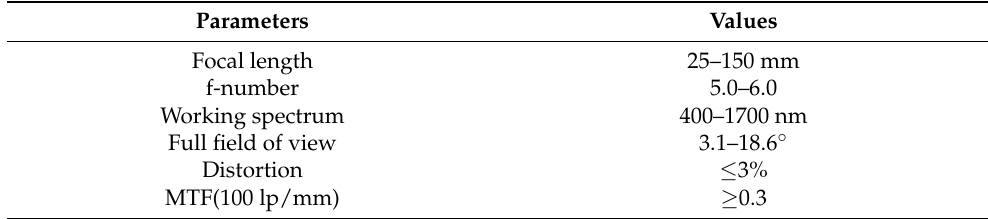
Table 2. Design specifications of the zoom optical